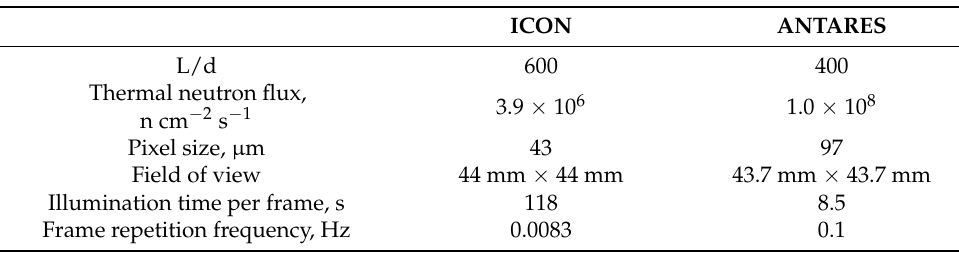
Table 1. Parameters of the in situ neutron radiography measurements.